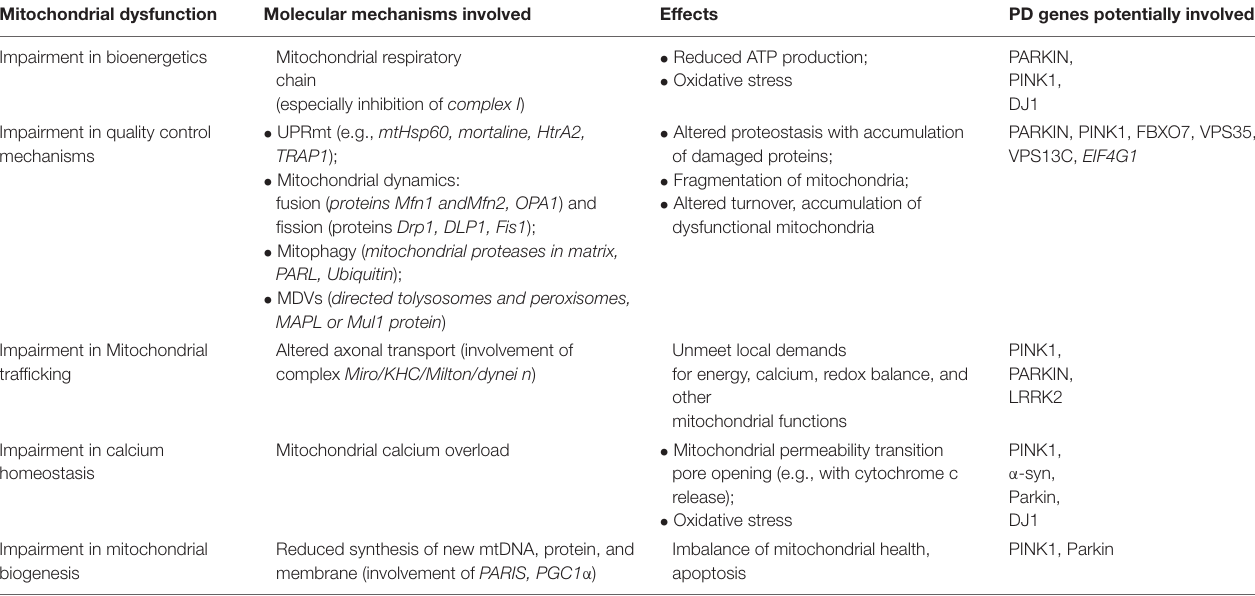
TABLE 1 | Multiple mechanisms underlying mitochondrial dysfunction in the pathogenesis of PD.